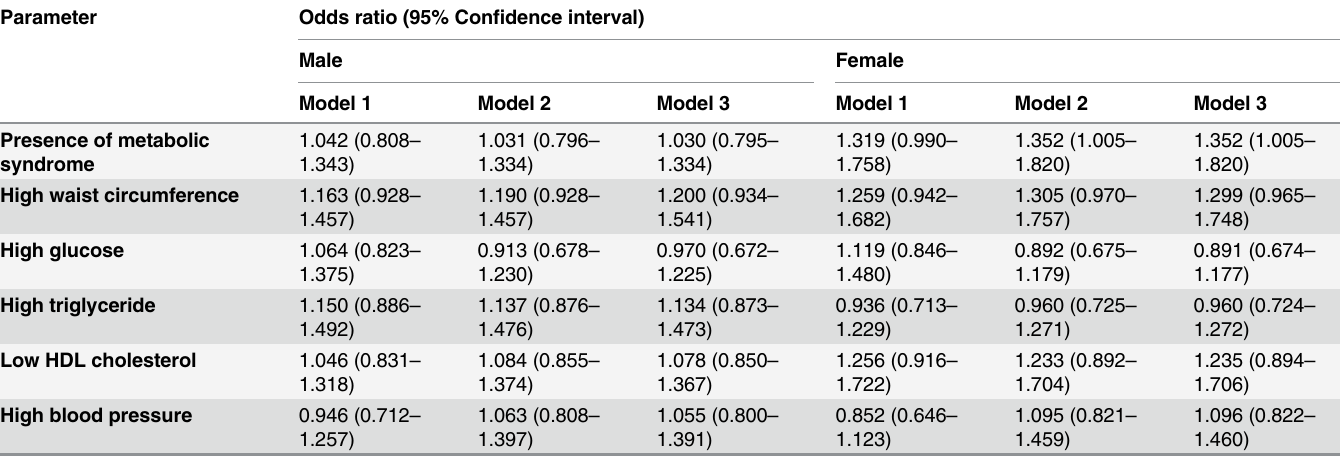
Table 3. Logistic regression models of metabolic syndrome for olfactory dysfunction by gender.